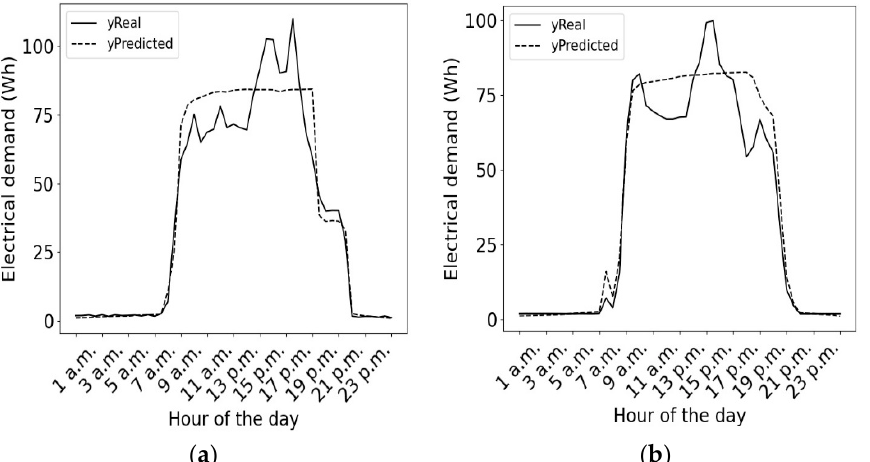
Figure 5. Comparison between the predicted electrical consumption with the SNN k-fold model and the actual consumption in a working day in the selected zone of the building. ( a ) Train/Dev sample division; ( b ) Test sample division.